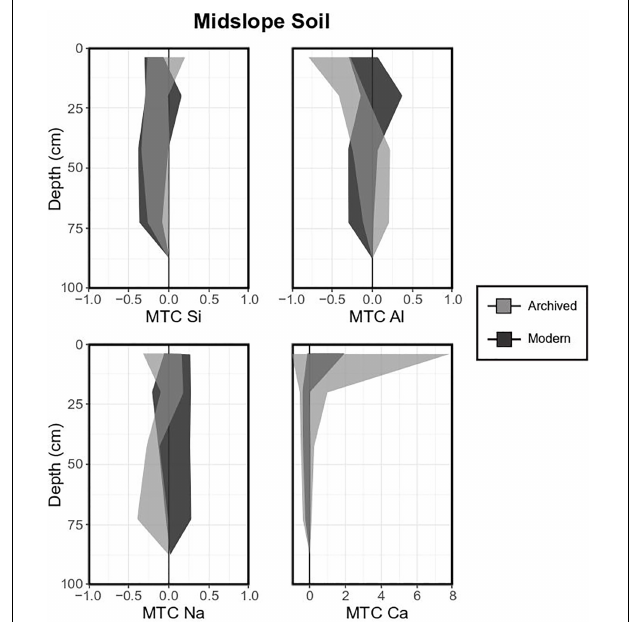
FIGURE 6 | Mass transfer coefficient (MTC) values of selected elements for a typical midslope soil (Inceptisol). Light gray shaded areas indicate standard deviations of means for each element measured in archived samples (1996, 18 pits), dark gray shaded areas indicate standard deviations of means for each element of modern samples (2017, 4